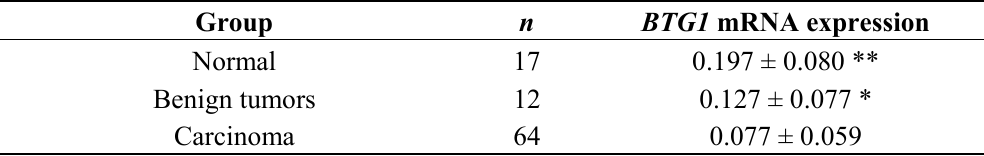
Table 1. BTG1 mRNA expression in ovarian epithelial